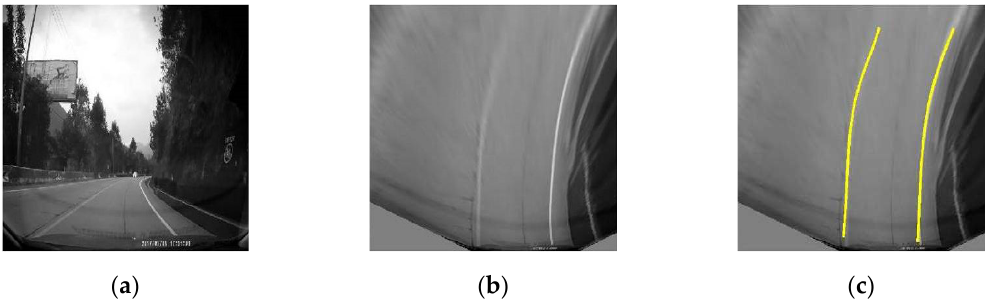
Figure 10. Unilateral lane line estimation: ( a ) Raw image; ( b ) Image of the aerial view; ( c ) Lane line marking.